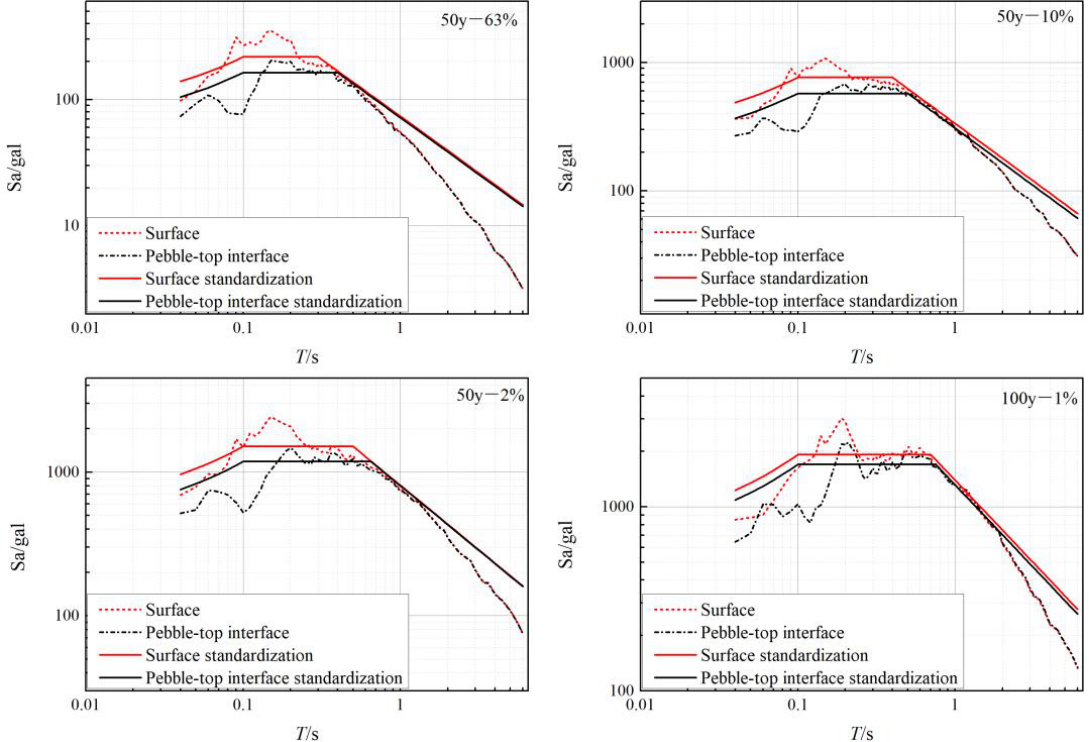
Figure 11. Accelerations spectra and standardization spectra of pebble-top interface and ground surface under four seismic inputs.